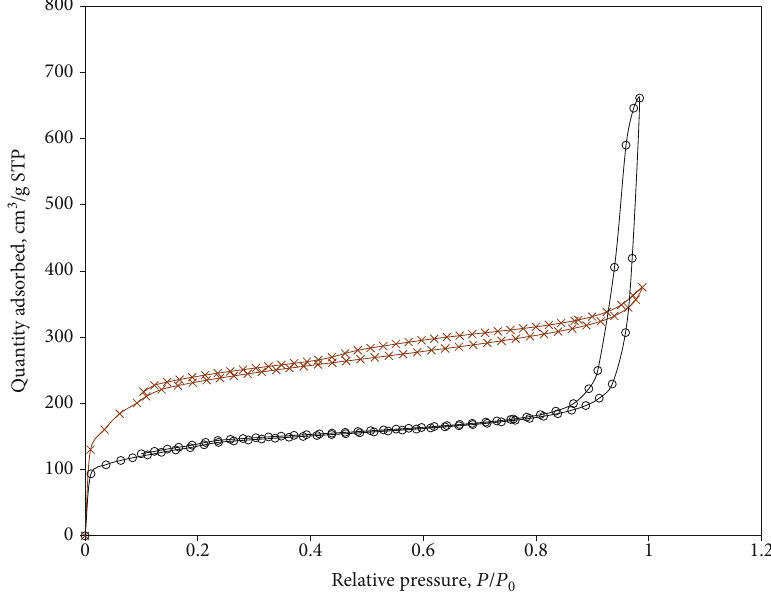
Figure 4: N adsorption-desorption isotherms (at -196 ° C) of (x) MIL-100-Fe and ( ○ ) 2